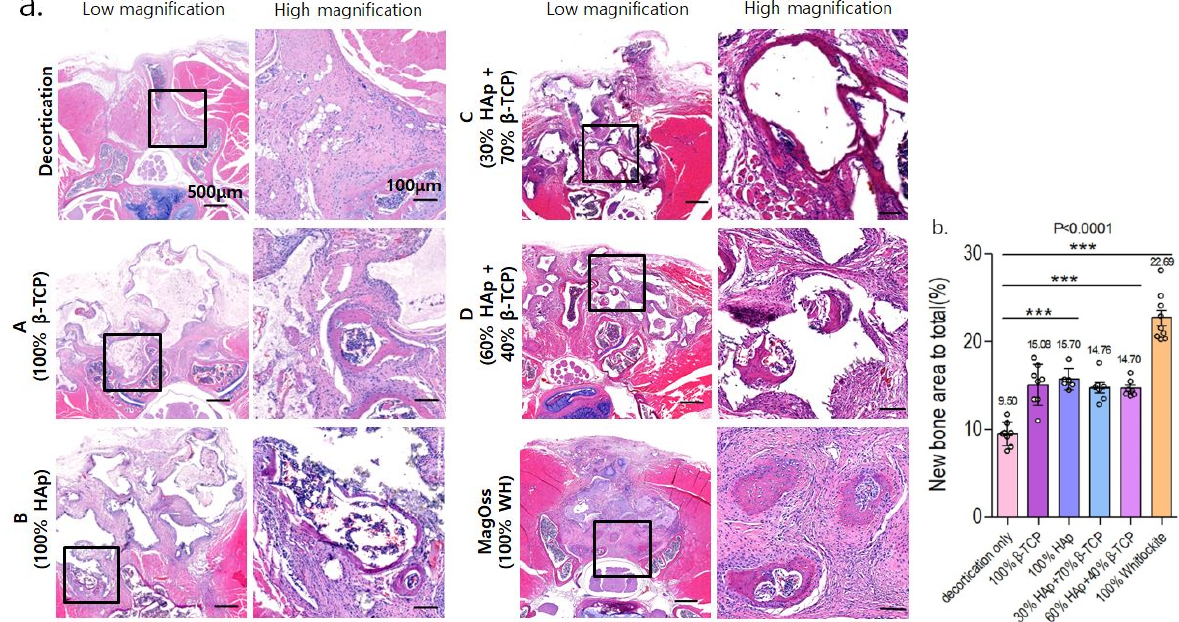
Figure 8. Histological analysis of bone regeneration in a spinal fusion model using hematoxylin and eosin staining. ( a ) Images of cross-sections from each group (scale bar = 500 μ m, 100 μ m). ( b ) Quantitative measurements of new bone area to total bone area (*** p < 0.0001). Data were expressed as the mean ± SE (decortication, A, B, MagOss: n = 9/C, D: n = 7).